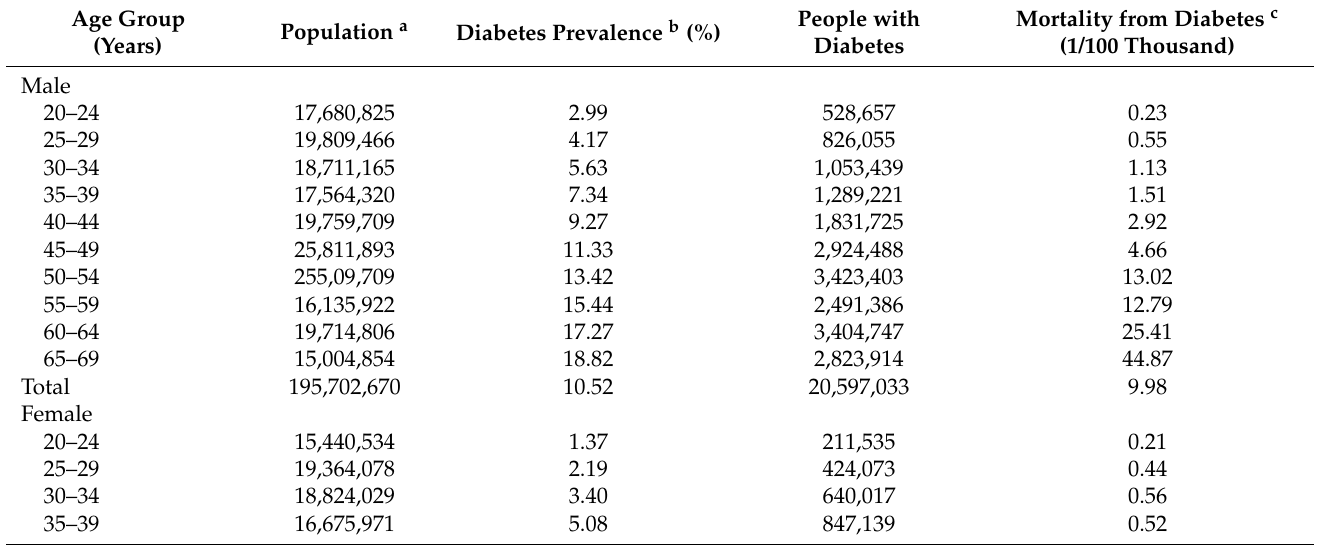
Table 2. Population, prevalence, and mortality of diabetes in rural China in